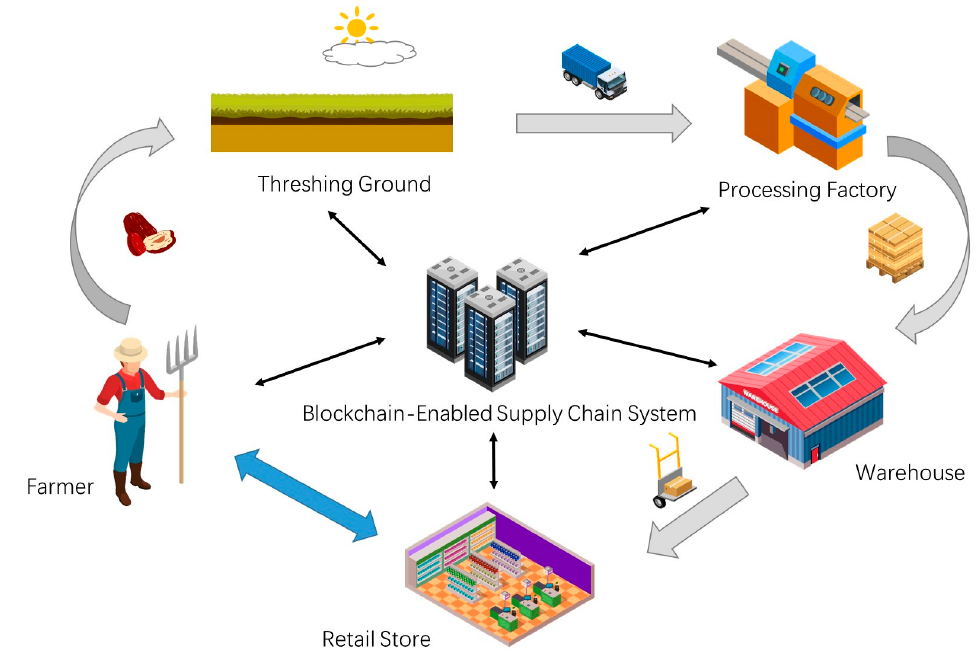
Figure 1. Application scenarios of blockchain-enabled jujube SCM framework.